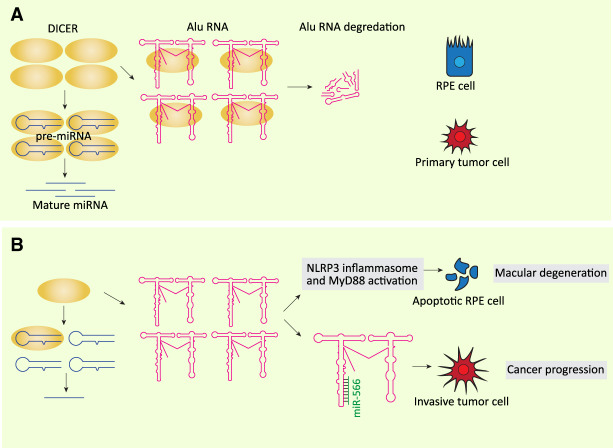
Alu RNA in diseases. (A) DICER is not only involved in miRNA maturation, but also degrades Alu RNA. (B) When DICER is down-regulated, increased levels of Alu RNA leads to cancer progression (Di Ruocco et al. 2018) and macular degeneration (Kaneko et al. 2011; Tarallo et al. 2012) through different mechanisms that are independent from miRNA deficiency. In RPE cells, Alu overexpression activates the NLRP3 inflammasome and MyD88, leading to cell apoptosis, whereas in colorectal cancer cells Alu RNA sequesters miR-566 leading to increased invasion capacity of the cells.